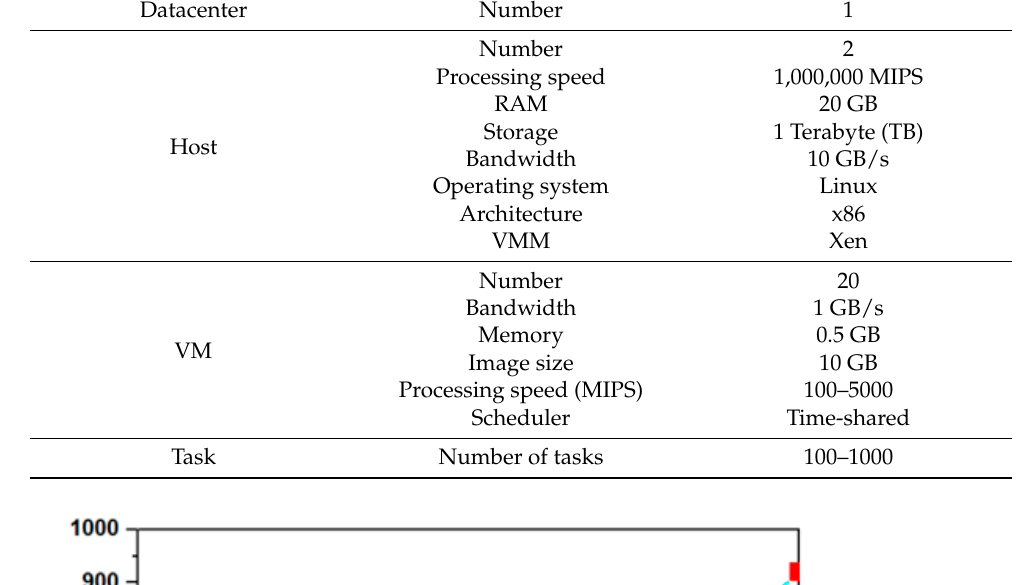
Table 3. Parameter settings for CloudSim.